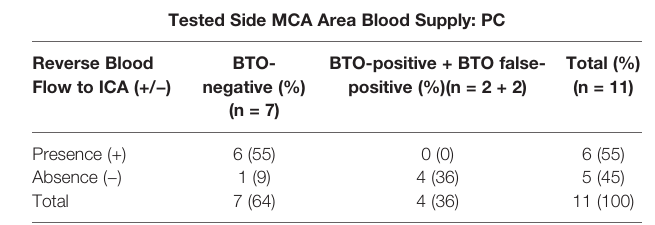
TABLE 1 | The summary of tested side MCA area blood supply categorization in TABLE 3 | The summary of the sigh of reverse blood fl ow to ICA tested side (Subgroup II + Type 6) and its BTO results for BTO alone group. MCA area blood supply in (Type 5 + Type 6) and its BTO results. BTO Alone Tested Side MCA Area Blood Supply: PC